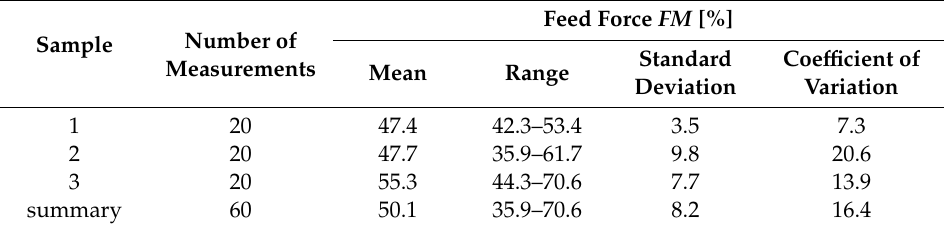
Table 7. Mean feed force test results.